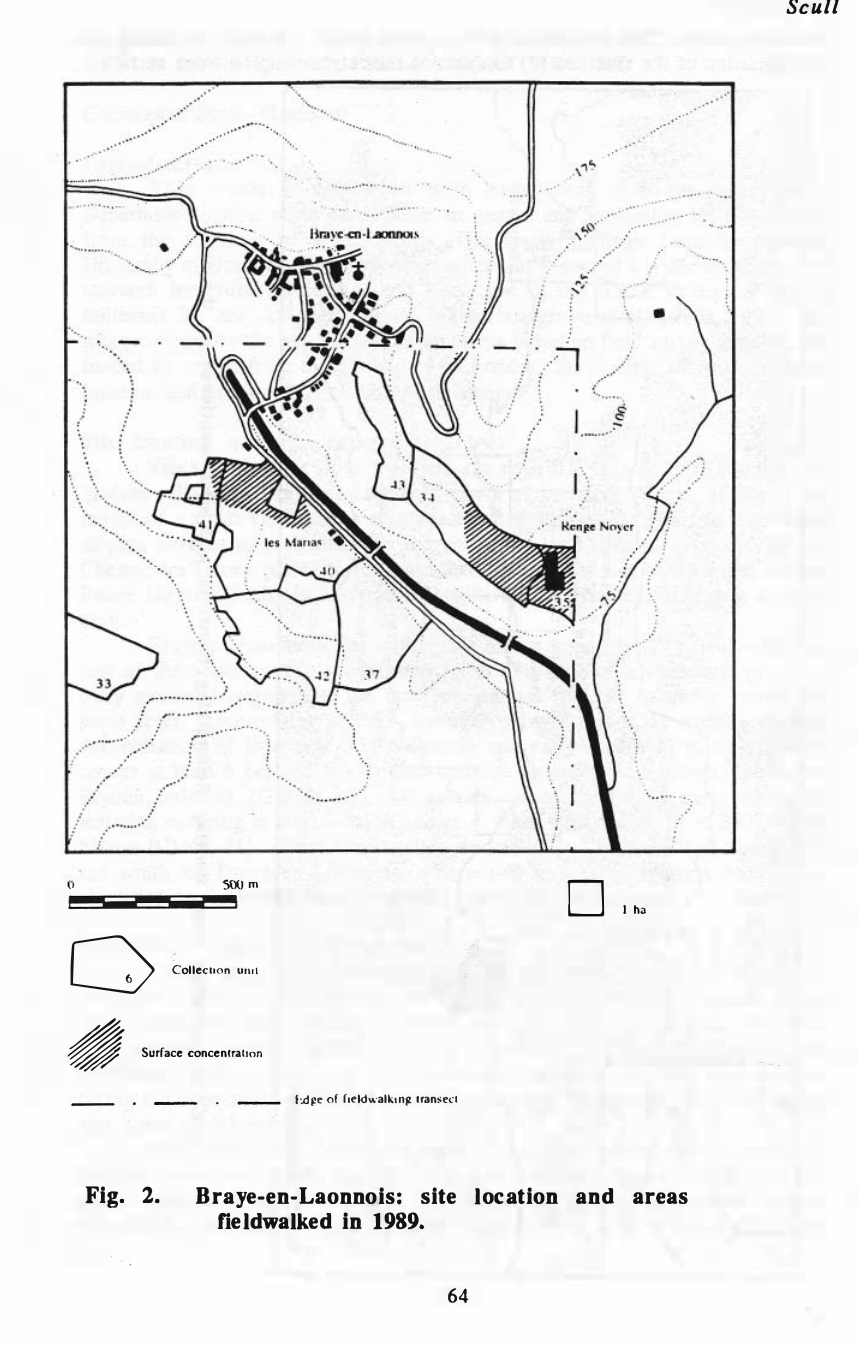
Fig. 2. Braye-en-Laonnois: site location and areas fieldwalked in